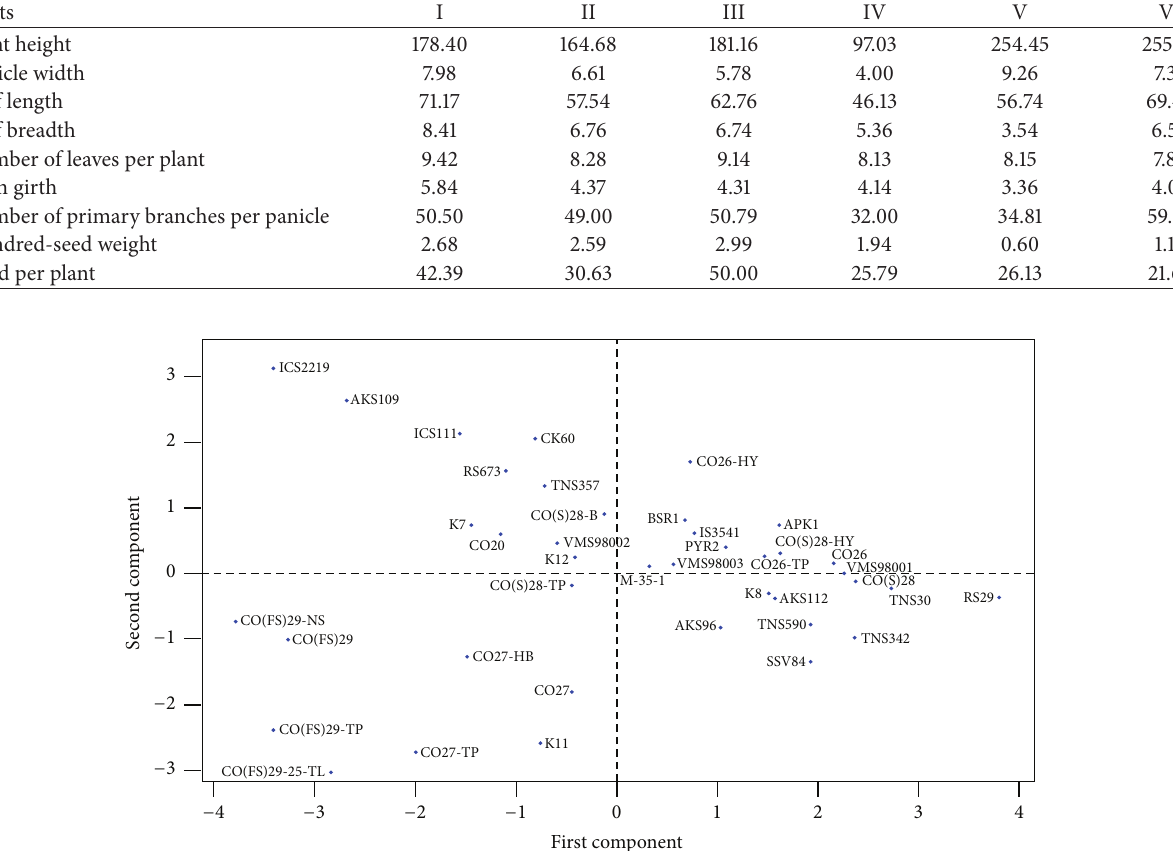
Figure 2: Distribution of sorghum accessions for first two principal components based on nine quantitative traits.